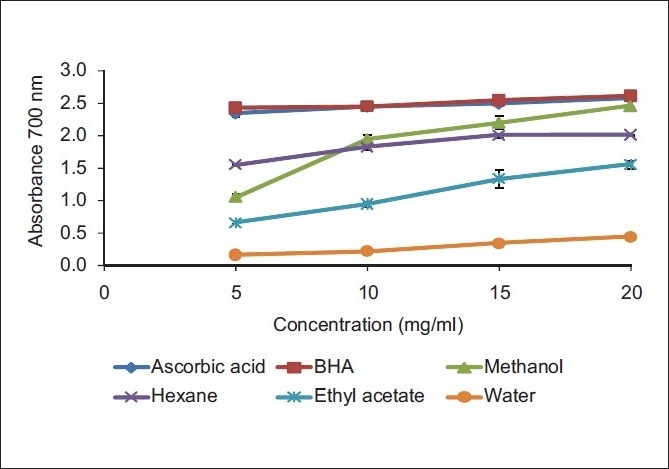
Reducing powers at various concentrations